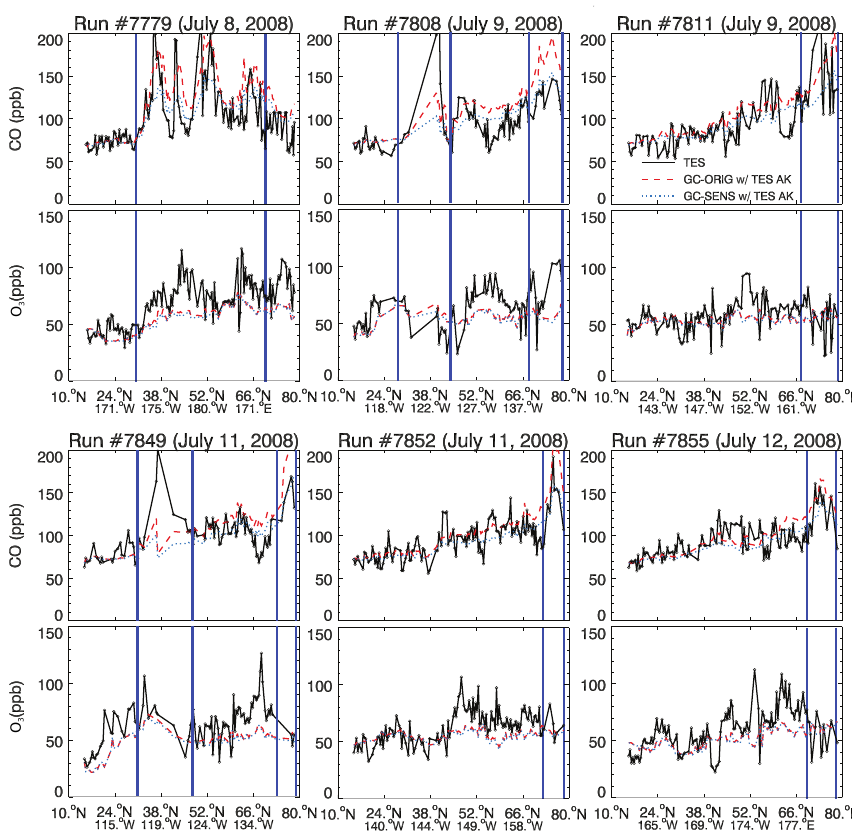
Fig. 16. Same as Figure 12 but for six TES runs influenced by biomass burning smoke from